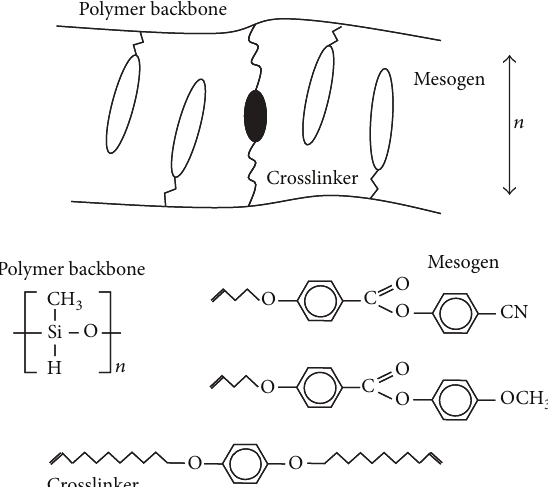
Figure 1: Top: sketch of one layer of polar mesogens and its crosslinker in a side-chain liquid crystal elastomer (LCE) with layer spacing larger than one pendant cyano mesogen. Below are the chemicalstructuresofthecompoundsusedtosynthesizeLSCEfilms 300 𝜇 m thick and several cm 2 area, with 7mol% crosslinker and 50, 70, and 100mol% of the polar cyano mesogens, respectively, CN50, CN70, and CN100. Fully extended, molecular lengths of the two mesogens are ℓ ∼ 20.5 – 21 ˚A. Including the siloxane as a chain extender adds another ∼ 2 ˚A to each monomer. The layer spacings are shown in Figure 2.